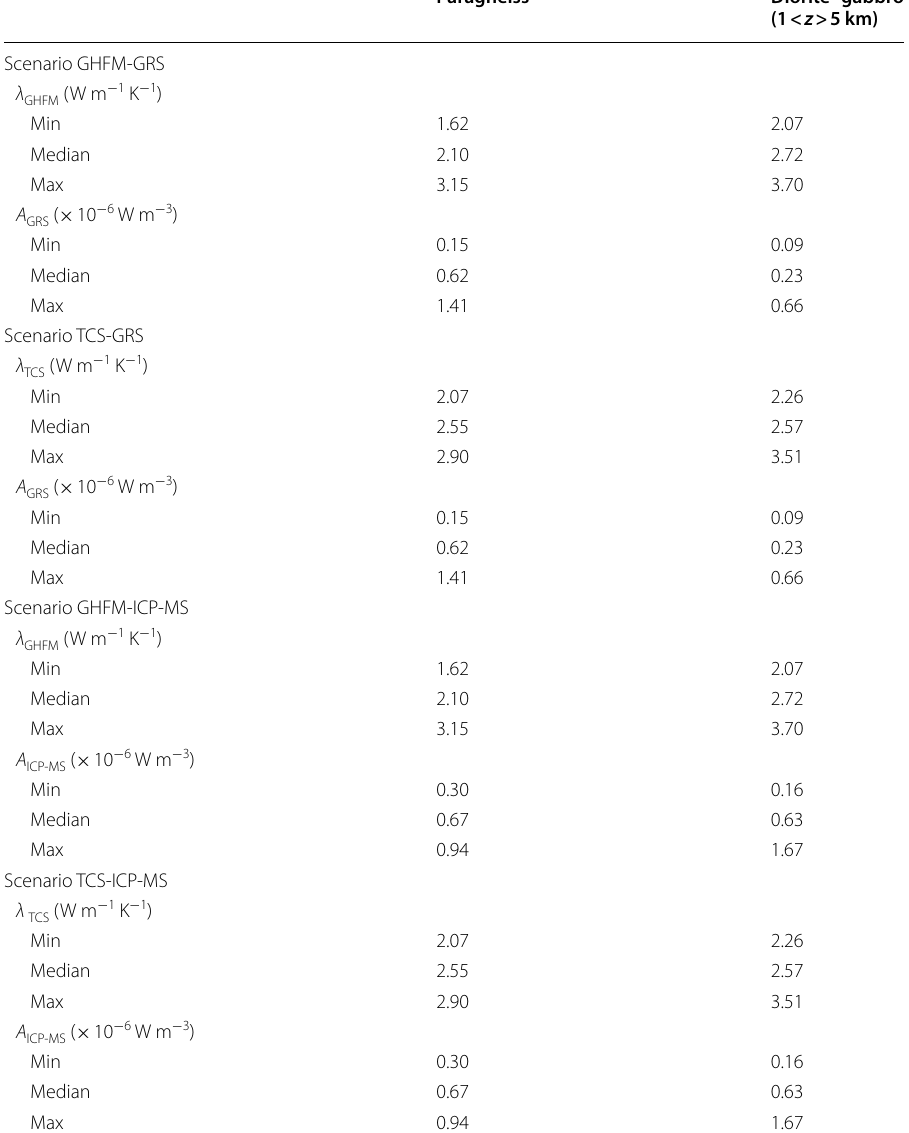
Table 4 Thermal property scenarios used in the numerical model to define the temperature at